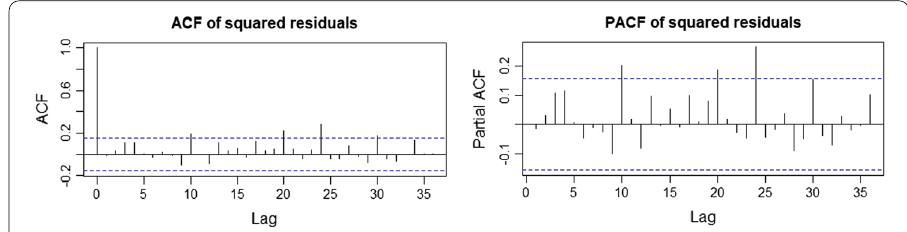
Fig. 6 The plot of autocorrelation and partial autocorrelation of the squared residuals from model in Eq.